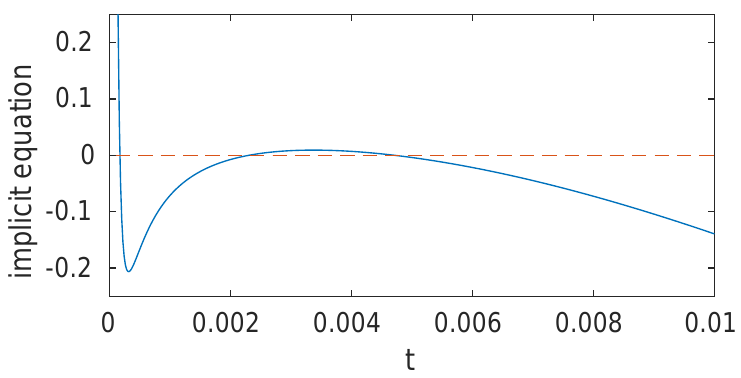
Figure 1. An example of multiple roots in the implicit Equation (22).